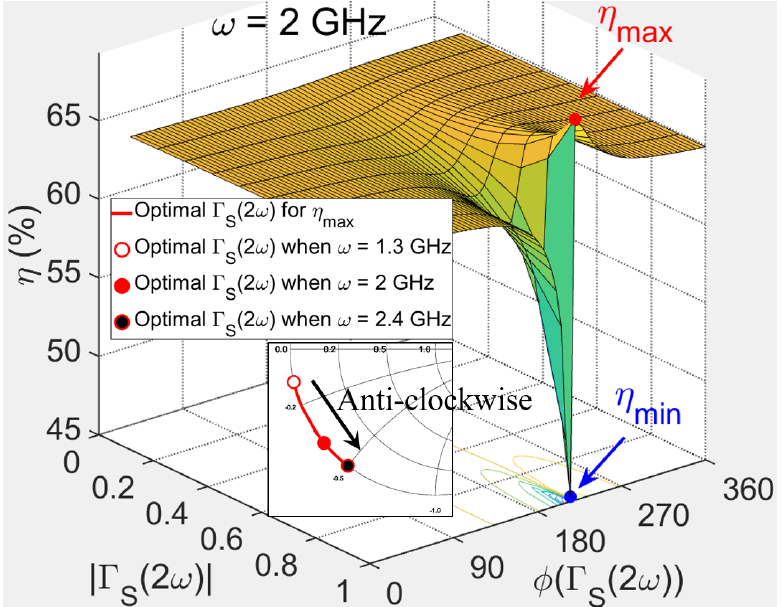
Figure 3. The subfigure shows an anti-clockwise trajectory of optimal input second-harmonic reflection coefficients, which can obtain optimal drain efficiency ( η max ) ) from 1.3 to 2.4 GHz. A three- dimensional drain efficiency figure demonstrates its strong dependency to input second-harmonic reflection